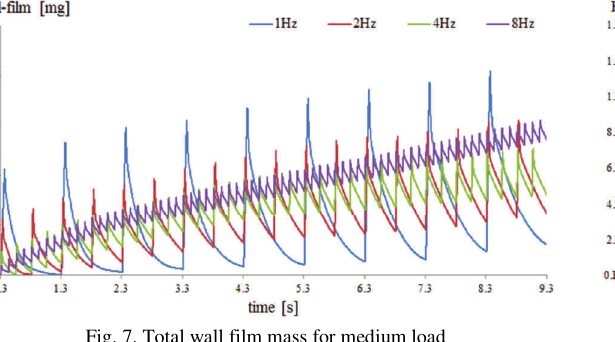
Fig. 10. Film coefficient for medium